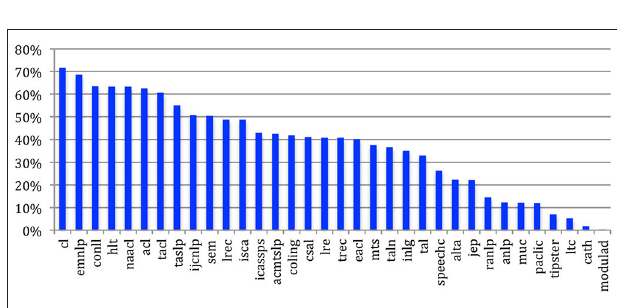
FIGURE 47 | Percentage of authors in the largest strongly connected component.